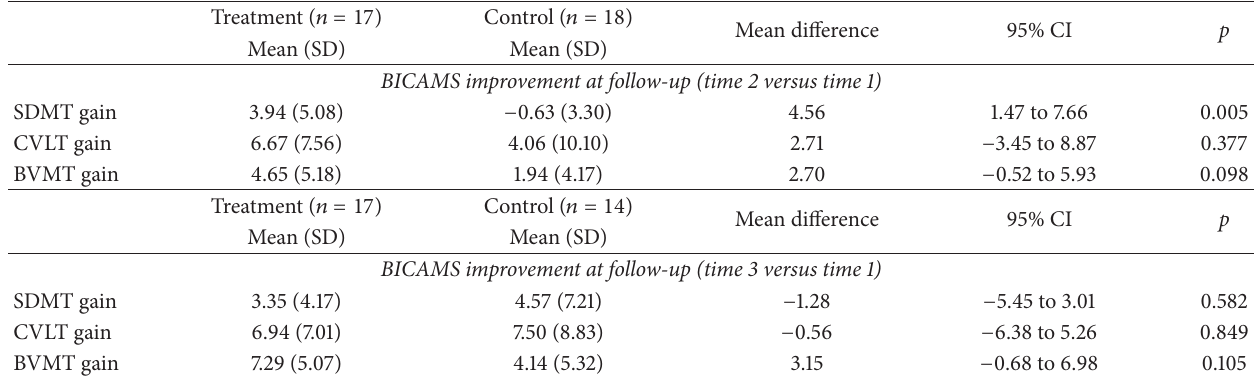
Table 2: BICAMS outcomes in treatment versus control